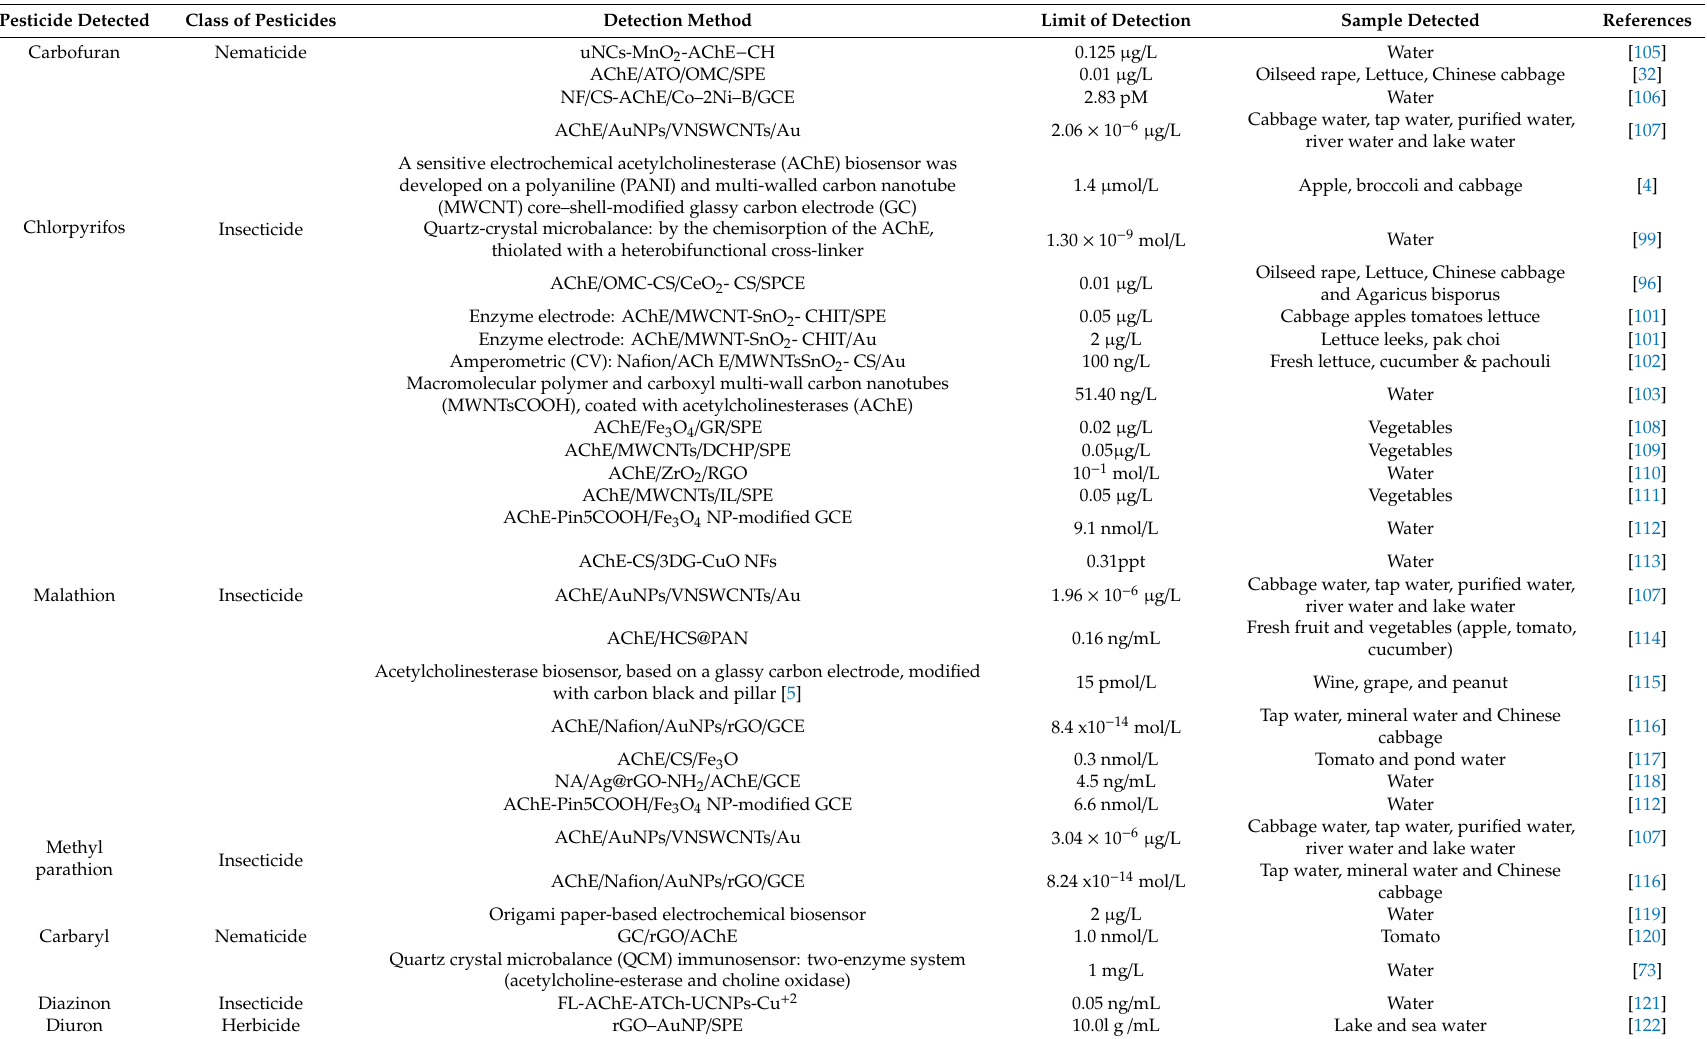
Table 4. Acetylcholinesterase biosensor developed for pesticides in fruits and in the